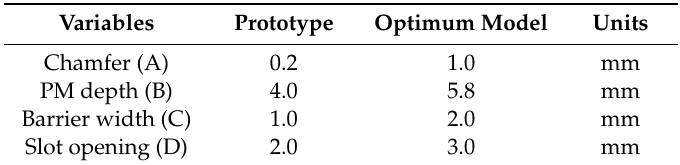
Figure 8. Optimum point of design variables considering design constraints. Table 4. Comparison of design variables.